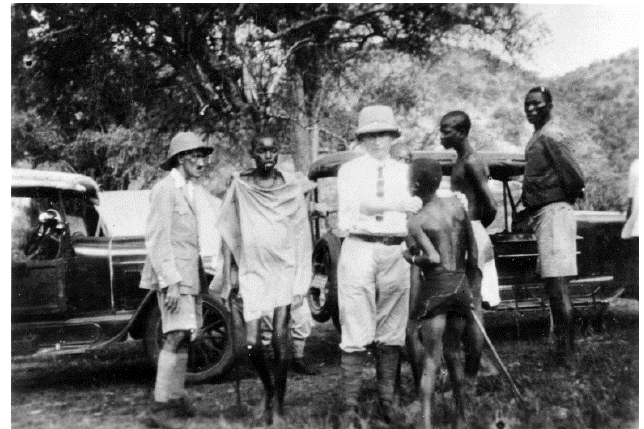
Figure 3. (Bayer Archive. Karl Friedrich Kleine with a Patient (Picture 0-3438301)) Friedrich Karl Kleine demonstrating the palpation of lymph nodes during screening of patients.